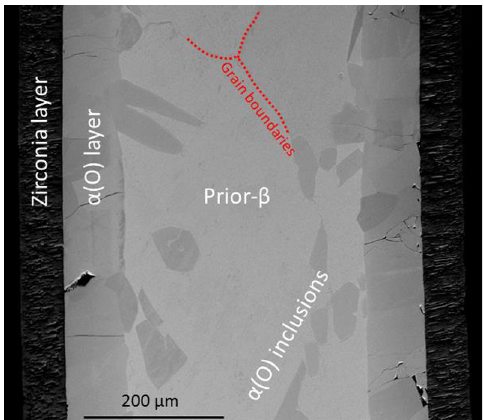
Fig. 4. SEM micrograph of Zircaloy-4 after oxidation at 1200 ° C during 400s